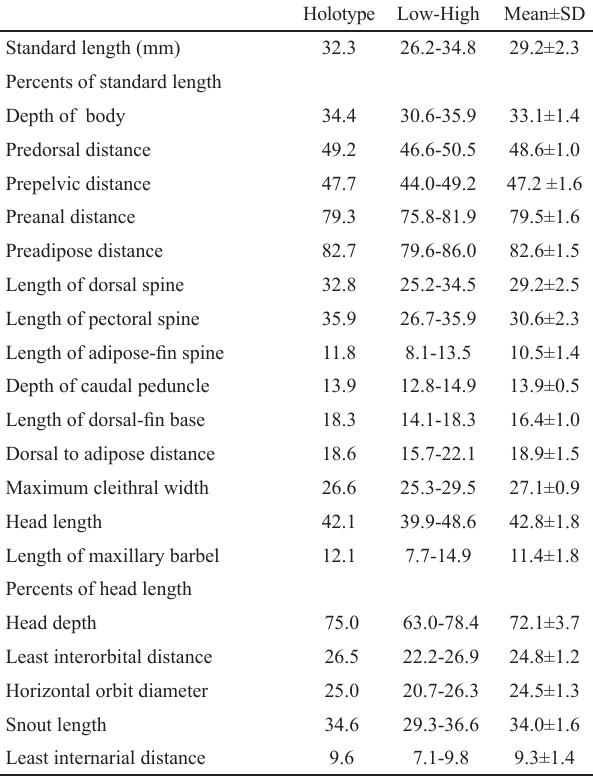
Table 1. Morphometric data of Corydoras gryphus . N = 20 specimens and SD = standard deviation.